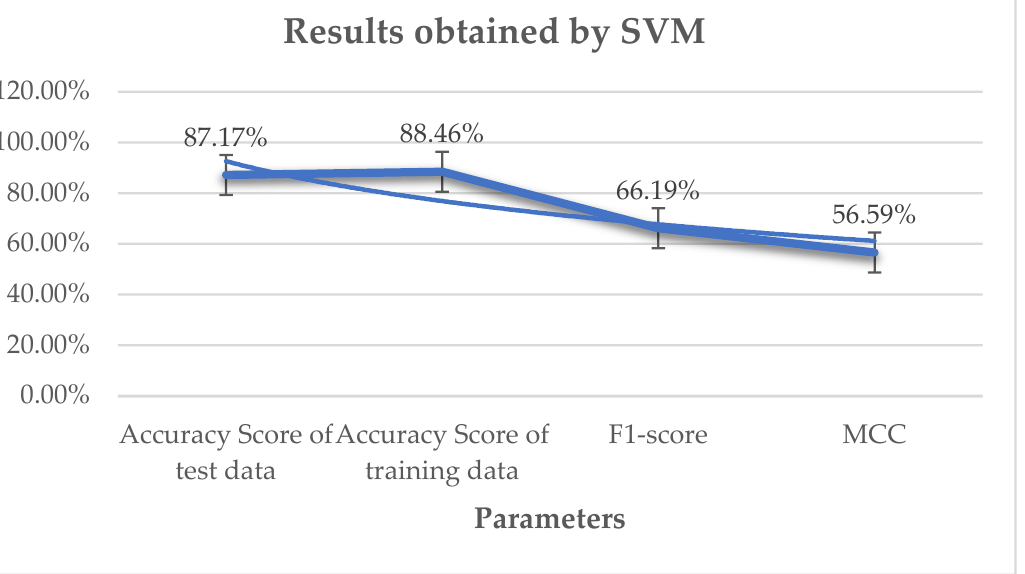
Figure 5. Results obtained by SVM.